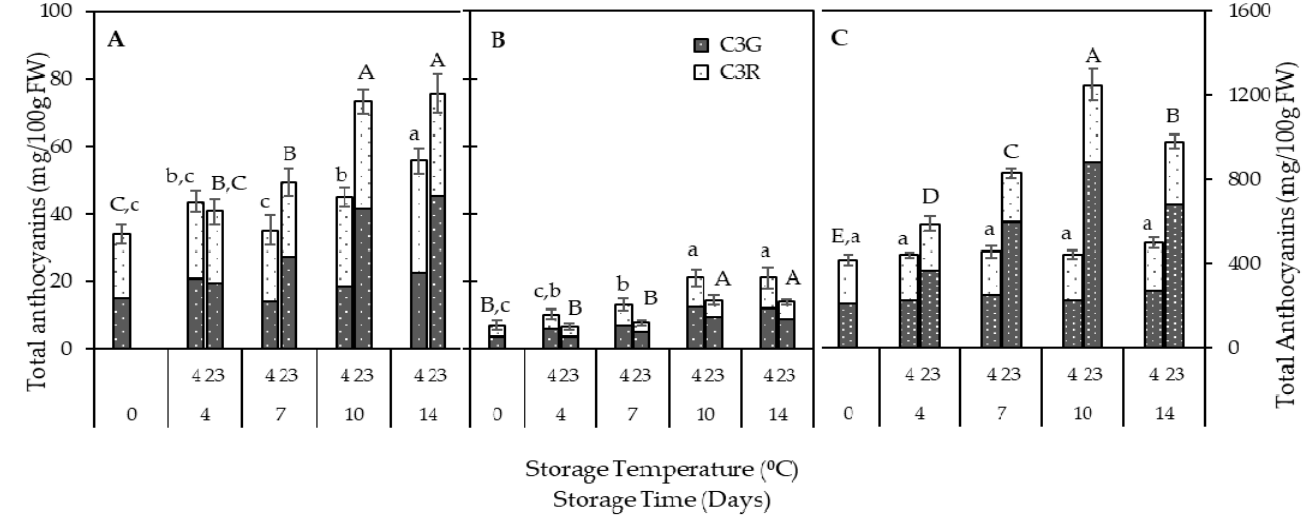
Figure 3. Anthocyanins in ( A ) outer flesh; ( B ) inner flesh; ( C ) peel. Data are presented as mean ± SE ( n = 6–10). Different uppercase letters indicate significant ( p < 0.05) differences between storage days at 23 °C, and different lowercase letters indicate significant ( p < 0.05) differences between storage days at 4 °C; C3G-cyanidin-3-O-glucoside; C3R-cyanidin-3-O- rutinoside.